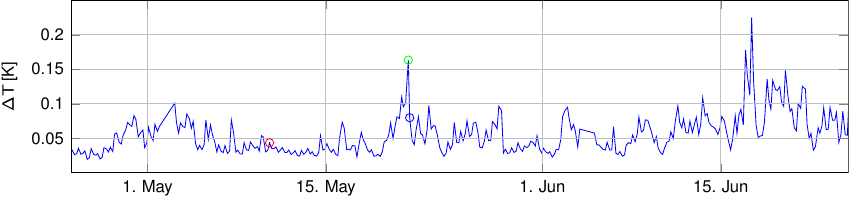
Fig. 7. 1 σ of the thermal noise from the OSO radiometer from the summer of 2005, estimated as described in the text. The measurements are performed with 3h integration time. The circles show the three days selected for further AVK analysis.